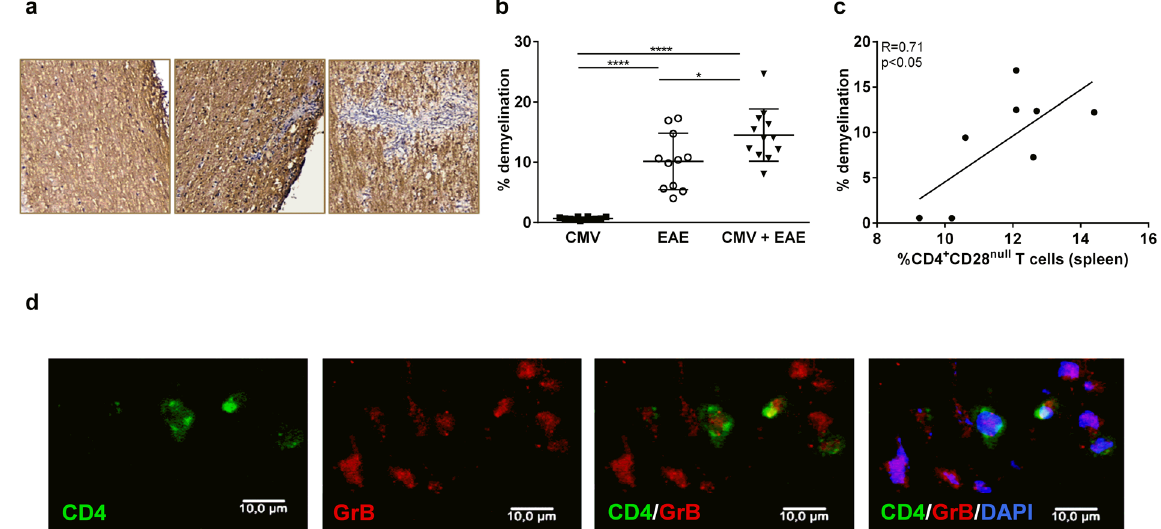
Figure 4. CMV infection increases EAE lesion size. ( a ) Representative staining of MBP in the CMV control group (left), the EAE control group (middle) and the CMV infected EAE animals (right). ( b ) The amount of demyelination within the CMV and EAE control groups and the CMV infected EAE group, calculated via dividing the demyelinated area ( = loss of MBP) in the white matter of the spinal cord, over the total white matter area for each section. ( c ) Correlation between the amount of demyelination for each animal and the percentage of peripheral CD4 + CD28 null T cells. ( d ) Single and double staining of CD4 and Granzyme B, which points to the presence of CD4 + CD28 null T cells, in the spinal cord of EAE mice. * p < 0.05, **** p <